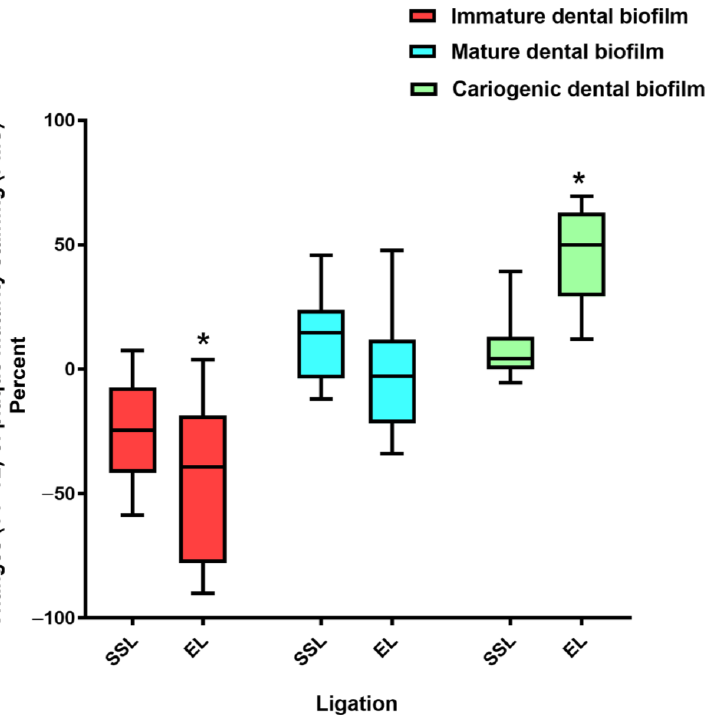
Figure 5. Comparison of plaque maturity staining (PMS) change before ligation (T1) and at the 4- week follow-up (T2) between the SSL and EL groups. Dental biofilm staining was performed at T1 and T2. The intervention was the combined horizontal – Charters – modified Bass tooth brushing tech- nique. The boxes represent the interquartile range, and the horizontal bars within the boxes repre- sent the median. The lower and upper ends of the vertical lines represent the 10th and 90th percen- tiles, respectively. The asterisks denote a significant difference in % PMS changes between the SSL and EL groups (Mann – Whitney U test, p < 0.05).